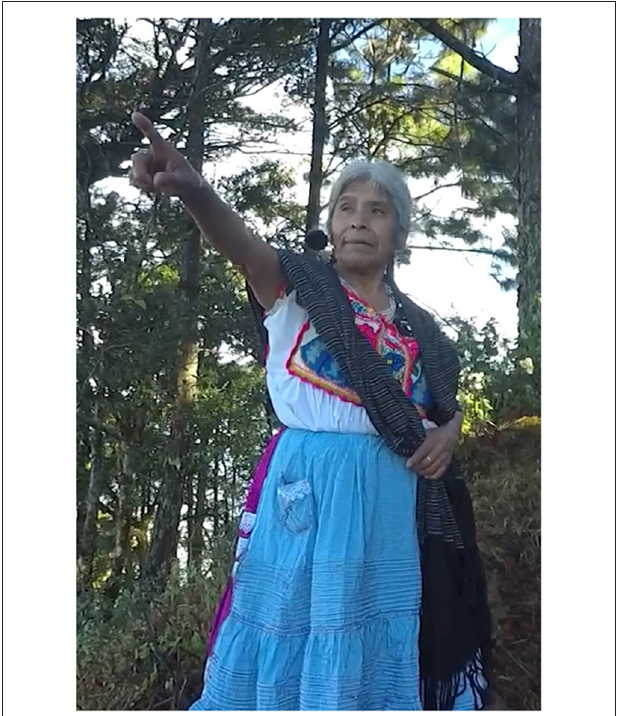
FIGURE 7 | Dem. + chin point [target: